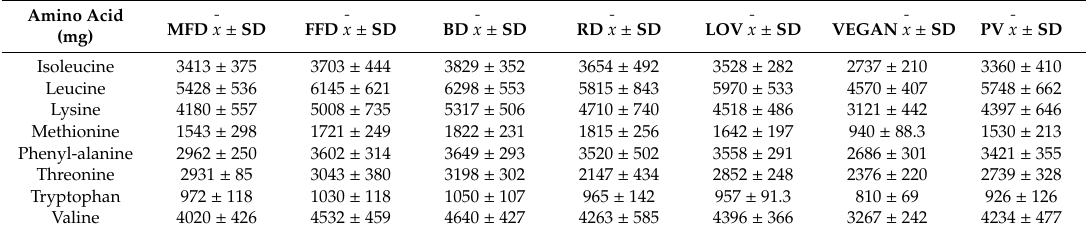
Table 3. The average content of exogenous amino acids in the analyzed diets (mg/day). Amino Acid